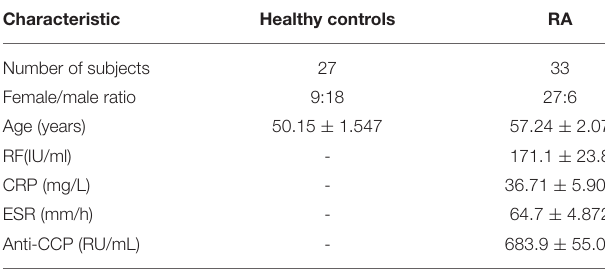
TABLE 1 | Clinical characteristics of Healthy controls and RA